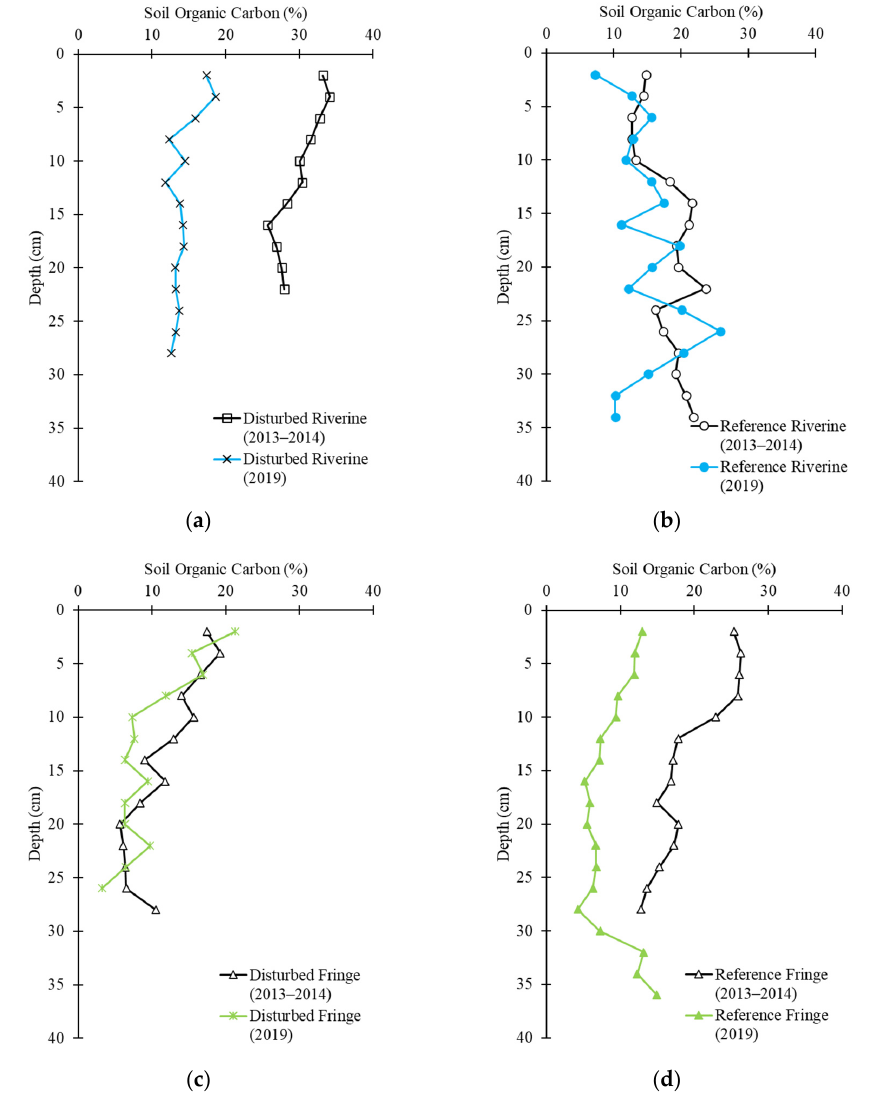
Figure 3. Soil organic carbon concentration in the period 2013–2014 and 2019 at each 2 cm soil depth in ( a ) the disturbed riverine site; ( b ) the reference riverine site; ( c ) the disturbed fringe site; and ( d ) the reference riverine site.